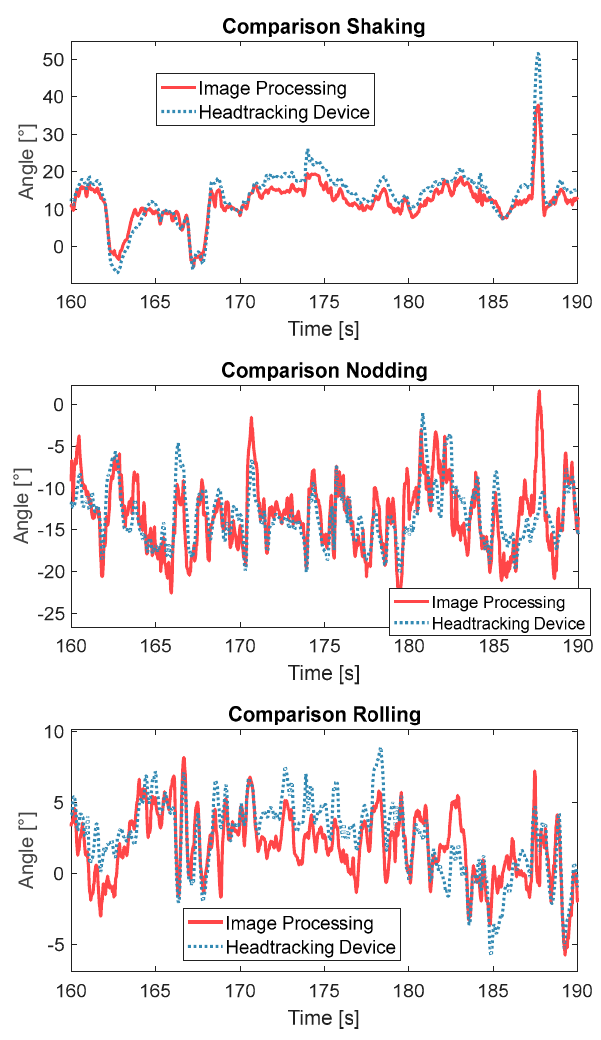
Figure 13. Comparison of head tracking for the proposed head tracking system (blue) and the camera-based tracking system (red) from the on-road experiments.